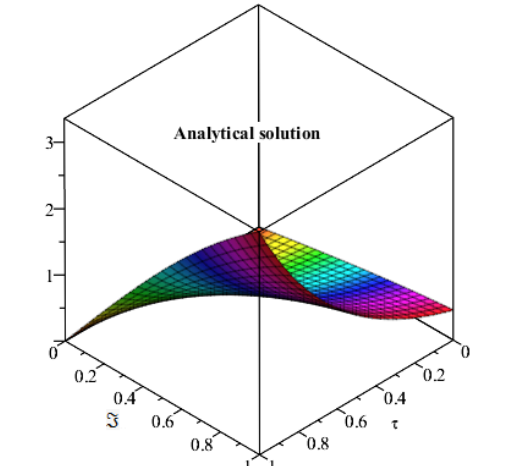
Figure 10. Represents the analytical solution of Example 3 at β = 1.